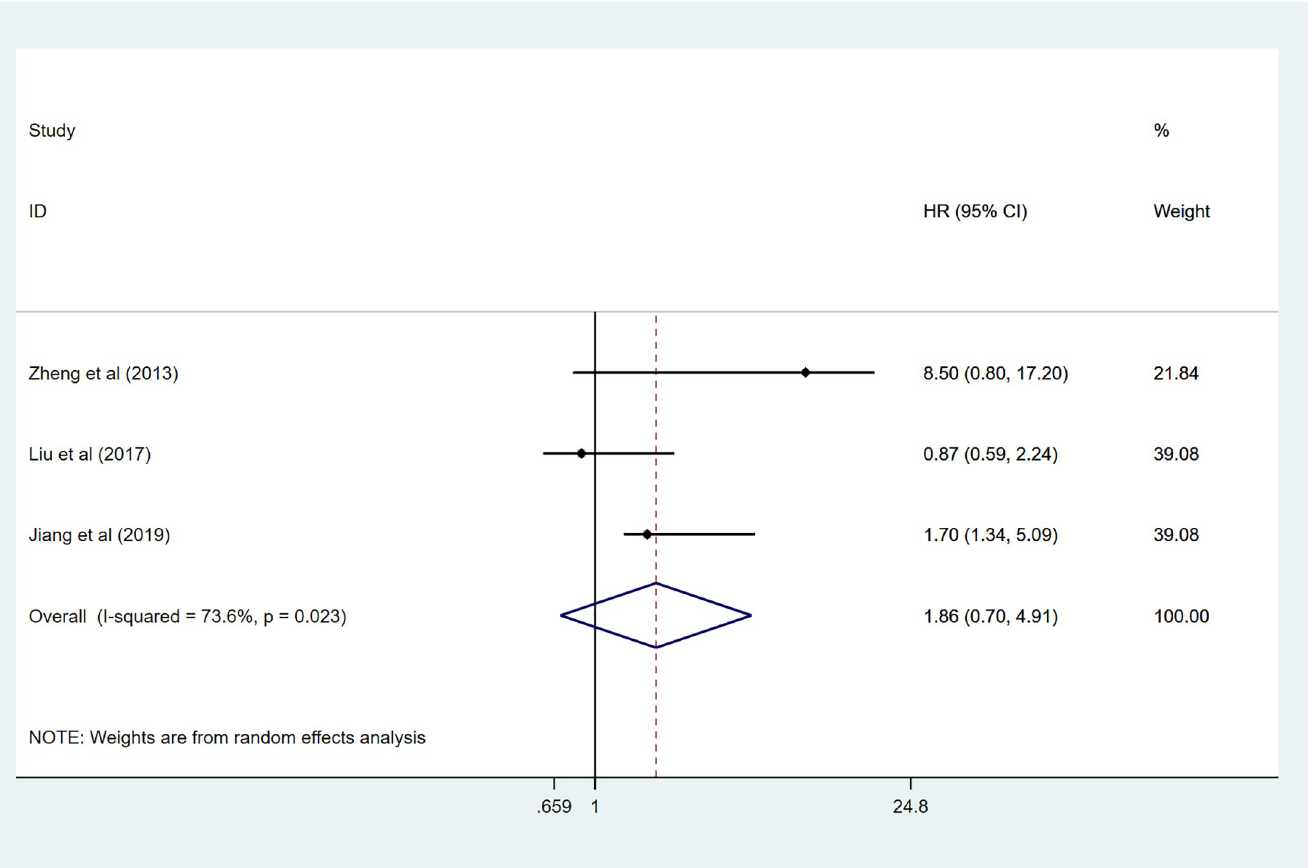
Fig 3. Forest plot for the association between GPRC5A expression and DFS.